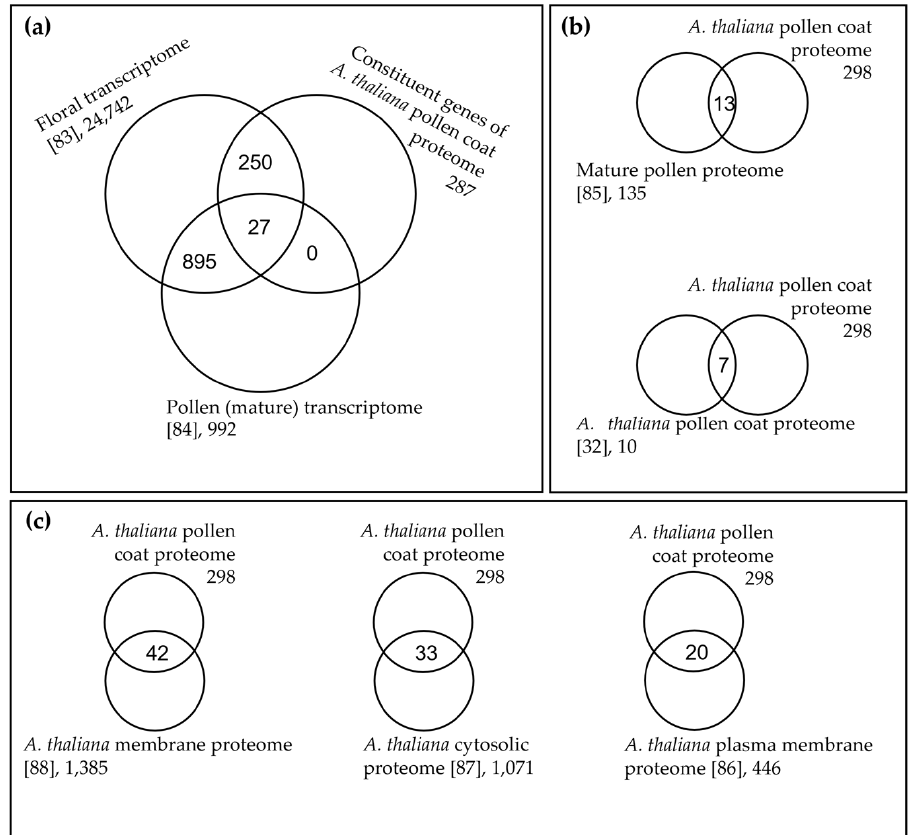
Figure 5. Overlaps of Arabidopsis thaliana pollen coat proteome or constituent genes with previously reported proteomes and transcriptomes. ( a ), Overlaps among constituent genes of A. thaliana pollen coat proteomes from this study, the floral transcriptome [83], and the pollen transcriptome [84]. ( b ), Overlaps of A. thaliana pollen coat proteomes from this study with a mature pollen proteome [85] and previously reported A. thaliana pollen coat proteomes [32], respectively. ( c ), Overlaps of A. thaliana pollen coat proteomes from this study with previously reported A. thaliana membranes and cytosolic proteomes, respectively